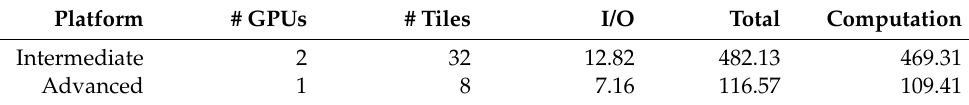
Table 9. Execution time (in minutes) for density estimation with ‘rule-of-thumb’ fixed bandwidth on the eBird dataset at 500 m resolution ( n = 13,806,513 points; geographic extent: latitudes 60° S–75° N).